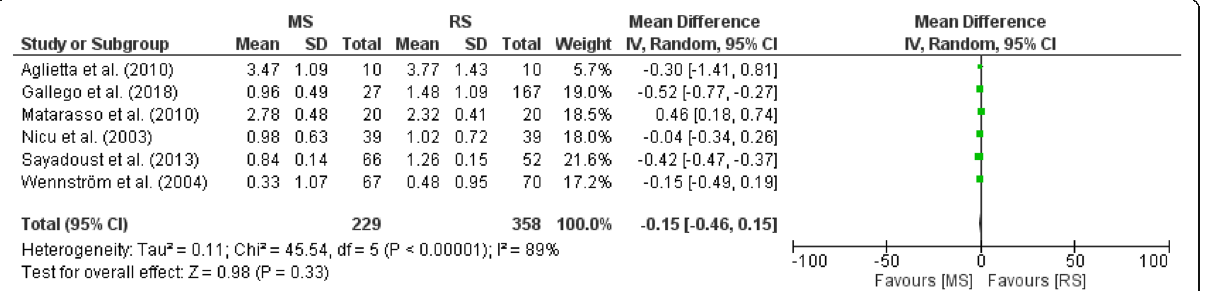
Fig. 4 Forest plot on differences in implant mean marginal bone loss between MS and RS groups in all included